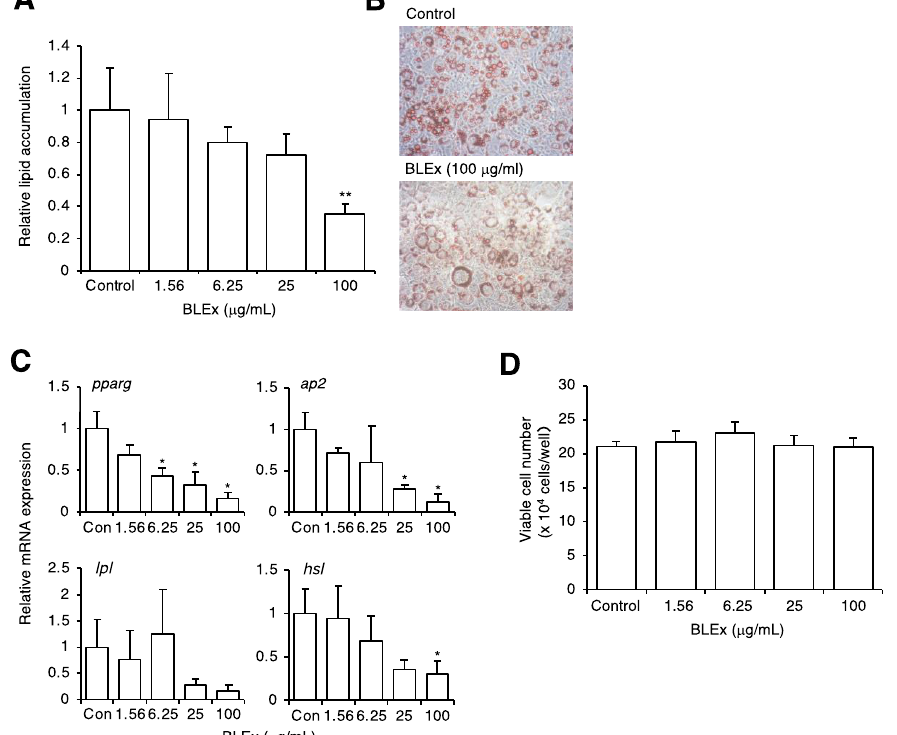
Figure 2. Effect of BLEx on the differentiation and maturation of 3T3-L1 cells to adipocytes. Data are means ± SE for 3 independent experiments. Statistical analysis was performed using one-way analysis of variance (ANOVA) and post hoc tests (Tukey–Kramer multiple comparisons). Asterisks indicate significant differences compared to the control at p < 0.05 * or p < 0.01 **. ( A , B ): Lipid accumulation was evaluated by Oil Red O staining and representative images are shown in B. ( C ): mRNA expression of adipocyte differentiation markers was measured by real-time PCR, and the data are shown as values relative to the mRNA expression of the internal control, gapdh. ( D ): Cytotoxicity of BLEx was evaluated as trypan blue exclusion